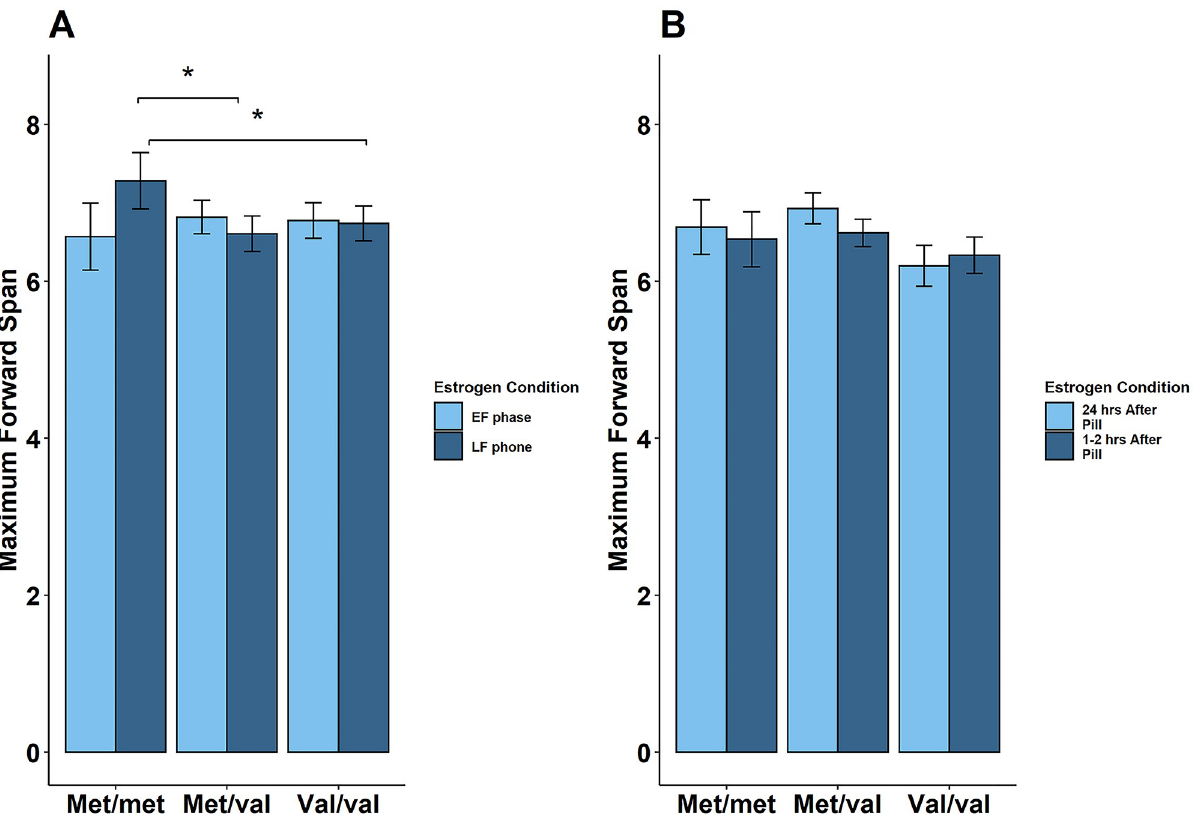
Fig 4. Estrogen condition interacts with COMT in the forward digit span. (A) Reduced sample with only NOC: Met/met NOC remembered more digits in the late follicular phase than met/val and val/val . (B) Reduced sample with only OC: No effect or interactions between EE condition and COMT were found. Error bars refer to SEM, � p < 0.05 Abbreviations: EF, early follicular, LF, late follicular, EE, ethinyl estradiol, hrs,